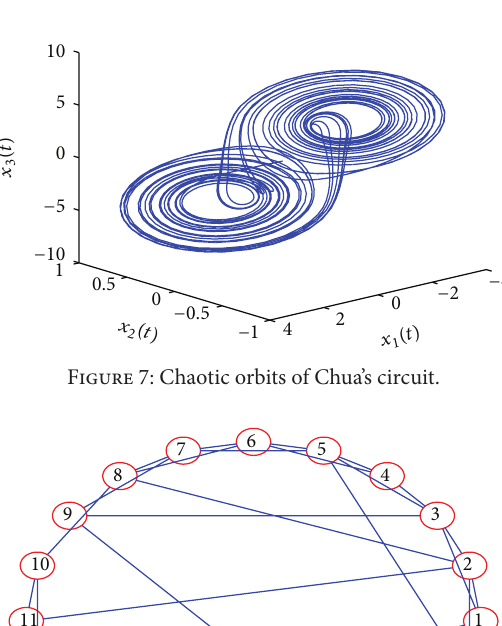
Figure 10: Correlation between 𝑘 and 𝛿 with given different 𝛼 .